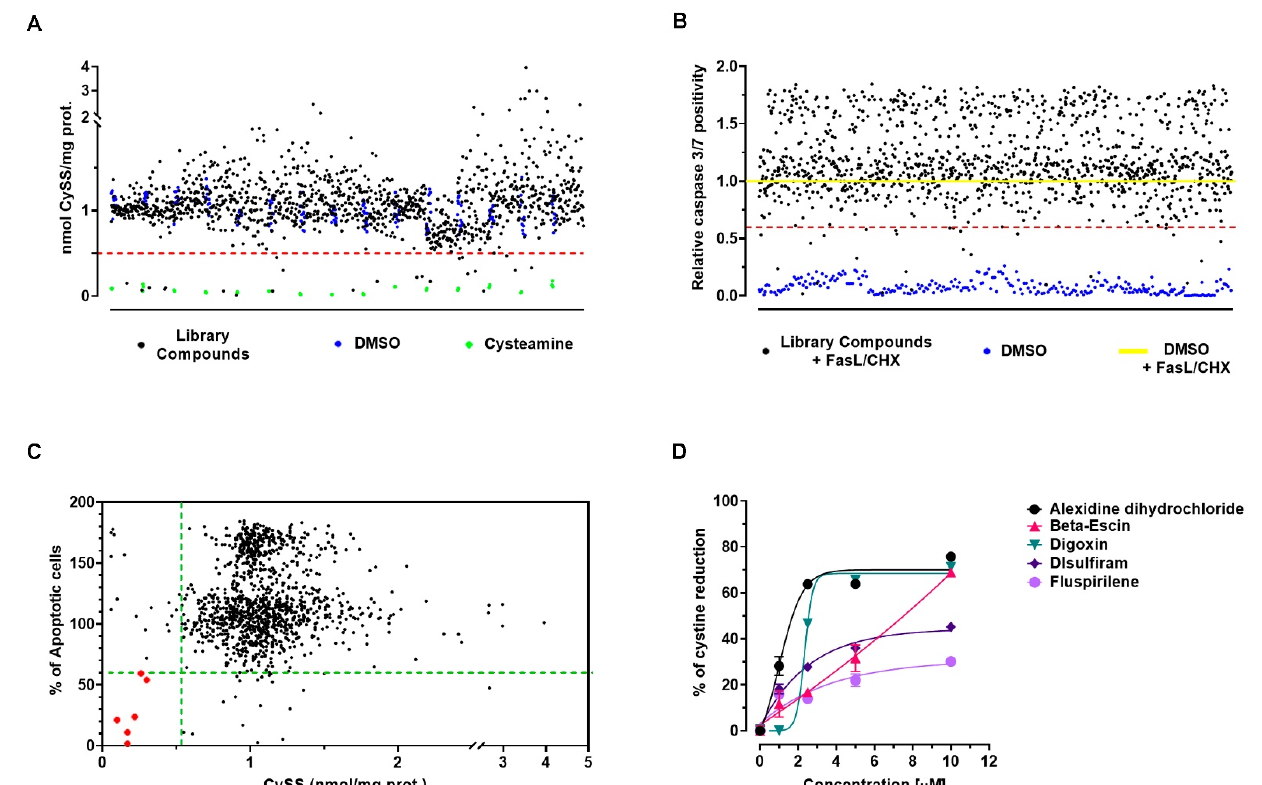
Figure 2. Drug screening for cystine content and apoptosis. ( A ) High throughput screening for cystine level normalized for protein content in CTNS − / − ciPTECs treated with 1200 small molecules of Prestwick chemical library and incubated for 24 h. Black dots: individual library compound at a final concentration of 10 µ M; blue dots: DMSO (vehicle as negative control); green dots: cells treated with 100 µ M of cysteamine (positive control). ( B ) High-content screening of small molecules that reduce apoptosis in CTNS − / − ciPTECs. Relative caspase 3/7 positivity of each well was shown; percent values of each well were normalized with the average percent of apoptosis in untreated cells exposed to apoptosis stimuli (yellow line) of each plate. Each black dot represents the mean value obtained with each compound. Blue dots show the same results for non-induced cells that were exposed to vehicle. After plotting the results, an arbitrary threshold was selected, which made it possible to identify 27 compounds that reduced by at least of 40% the apoptosis rate (red dash line). All experiments were performed in triplicates in different plates. ( C ) HTS and HCS data sets for cystine content and apoptosis rate were combined in a single plot, allowing to identify 6 drugs that potentially corrected both phenotypes (red dots). ( D ) Dose-response curve of cystine-depleting lead compounds was generated using four-parameters logistic regression model to interpolate data.